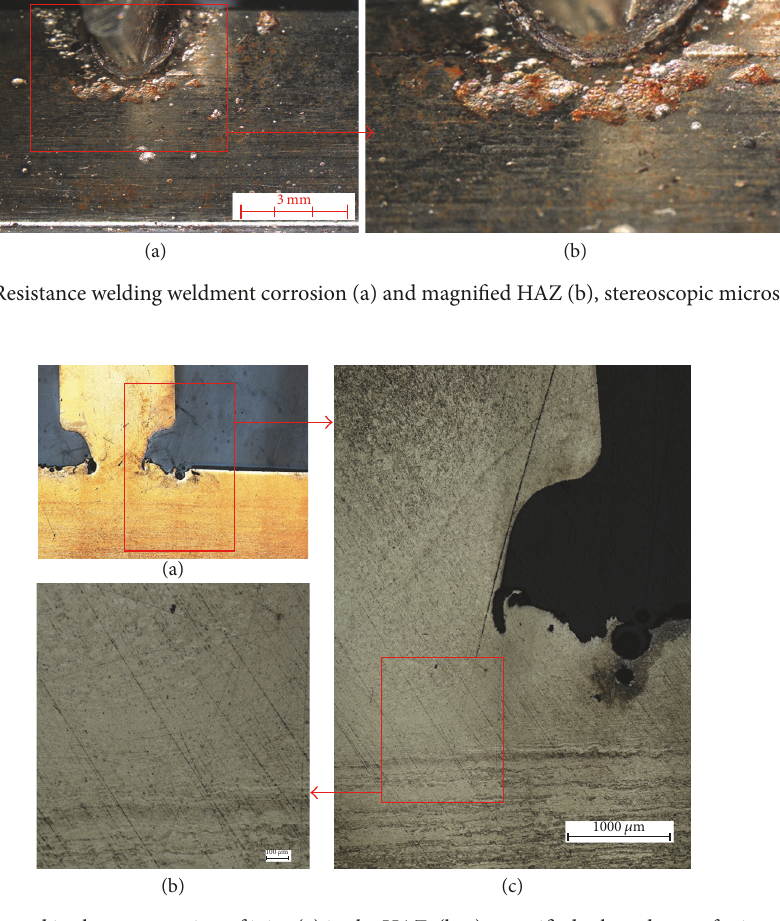
Figure 3: Corrosion pits observed in the cross section of joint (a) in the HAZ; (b, c) magnified selected area of microstructure of base metals and heat affected zone presented, metallographic